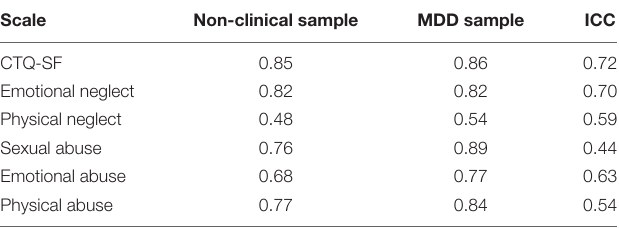
TABLE 5 | Cronbach’s α values and ICC for CTQ-SF and